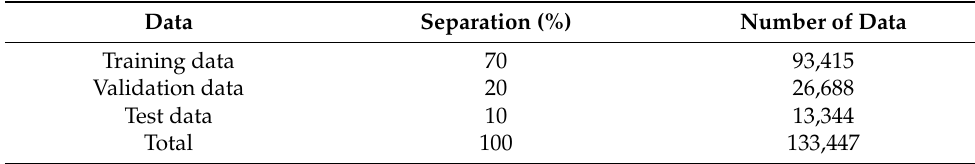
Table 3. Data separation for deep